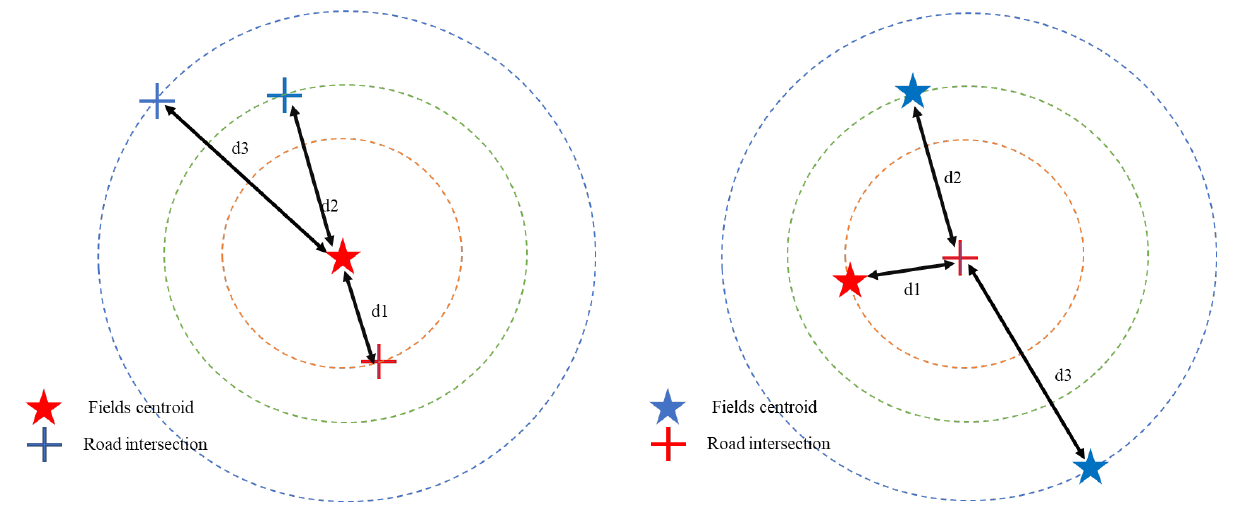
Figure 4. Data conversion of road nodes to centroids ( left ) and centroids to road nodes ( right ). Distances d1, d2, and d3 represent distances from centroids to road nodes, with d1 being the shortest one.